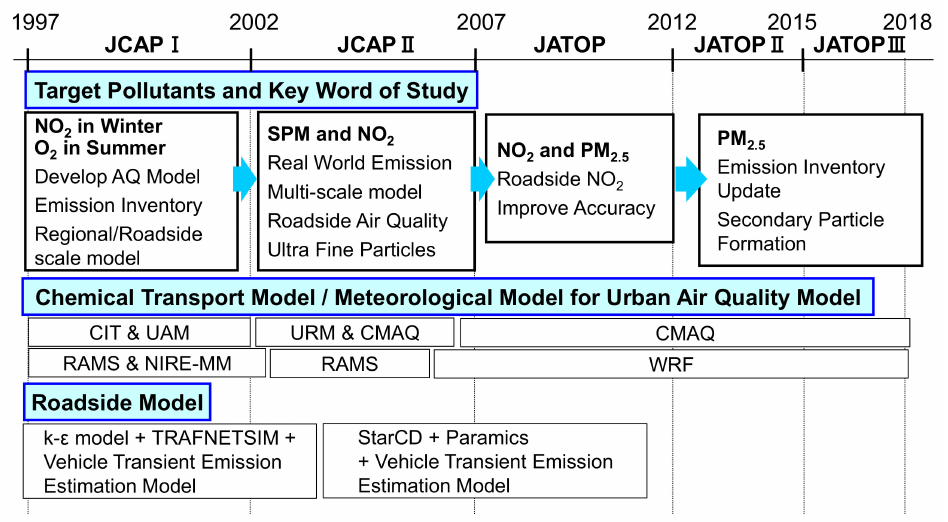
Figure 3. Overview of the 21 years of the JCAP/JATOP Air Quality Model